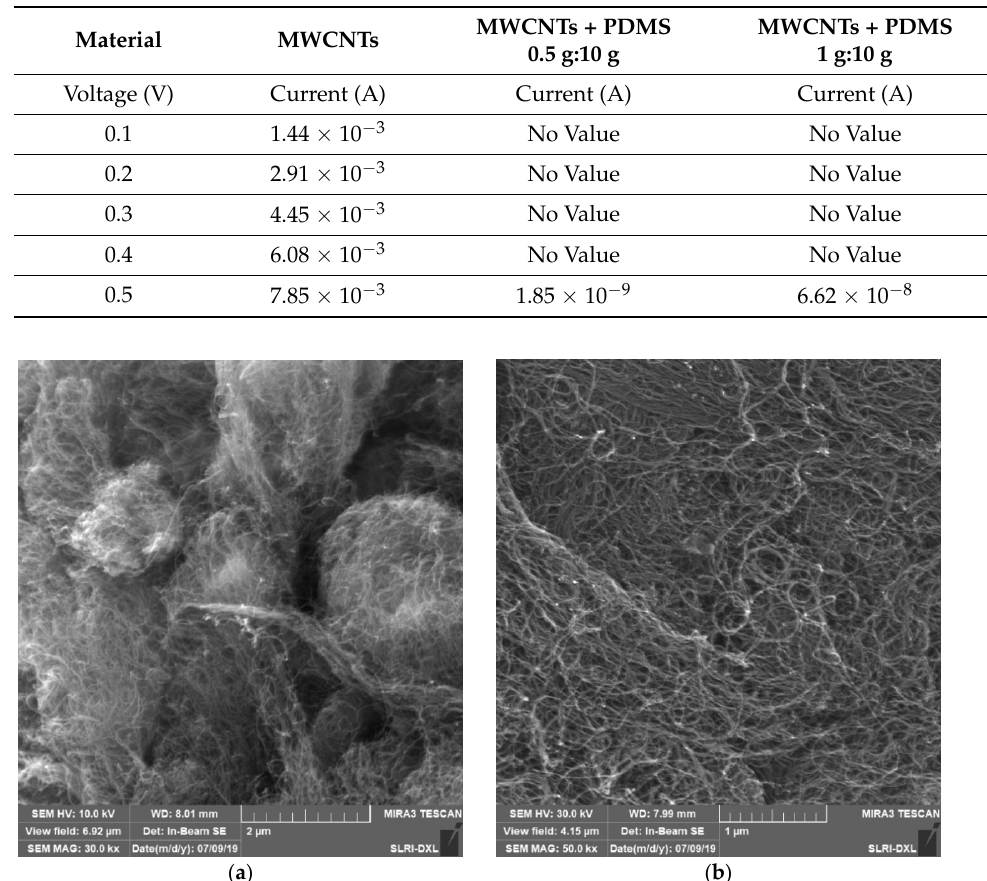
Figure 2. ( a ) Scanning electron micrograph of multiwalled carbon nanotubes powder at 1000× mag- nitude and ( b ) Scanning electron micrograph of multiwalled carbon nanotubes bulk at 3000× mag- nitude. Table 1. Conductivity data of MWCNTs for created in Microfluidic chip.